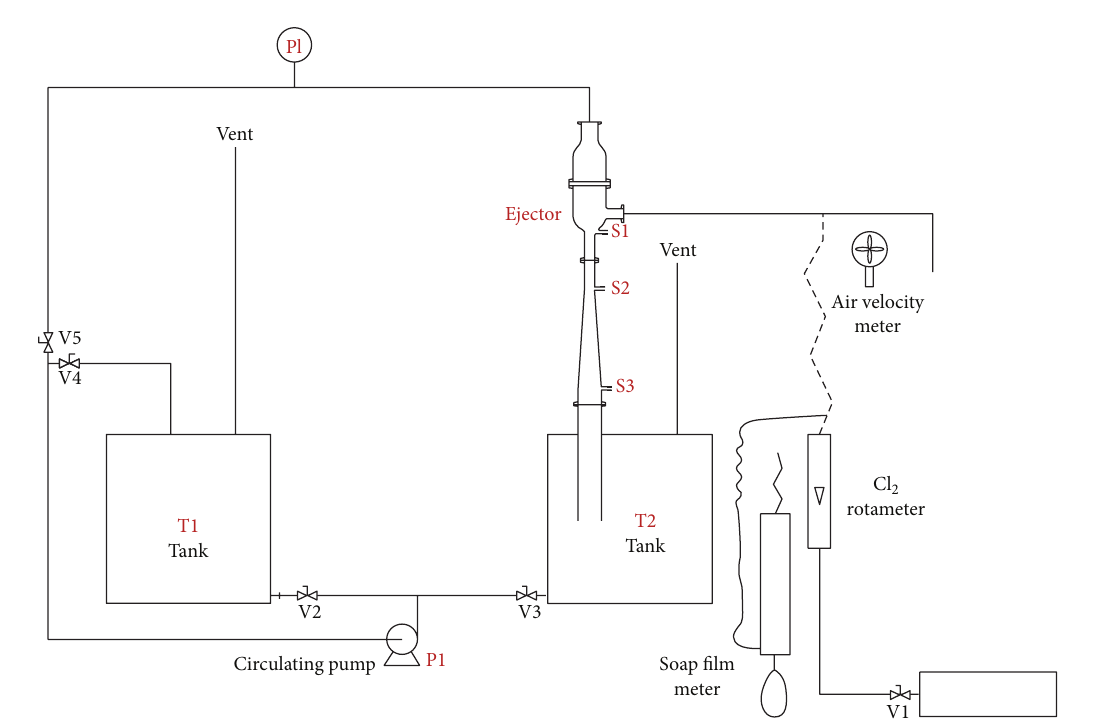
Figure 4: Schematic diagram of the experimental setup [31, 111,